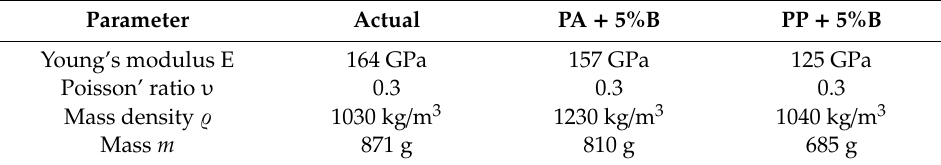
Table 1. Main mechanical properties of the materials considered in the numerical models.